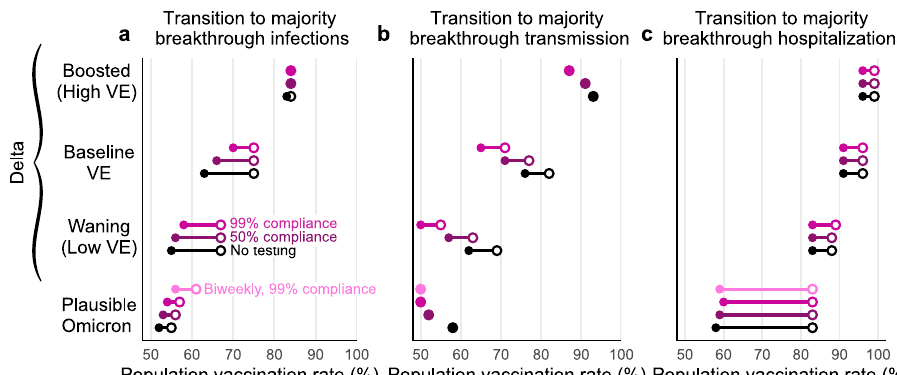
Fig. 7 Screening and vaccine effectiveness affect transition points to majority-breakthrough regimes. The vaccination rates at which the vaccinated population makes up the majority of a infections, b transmission, and c hospitalizations for low, moderate, and high vaccine effectiveness scenarios. Minimum ( fi lled circle) and maximum (open circle) endpoints show the variation in transition points over all combinations of vaccination and prior infection rates for no screening (black), 50% compliance (purple), 99% compliance (pink) over all possible values for past infection rates. R NPI plots; see Supplementary Fig. 7 for R NPI ¼ 0